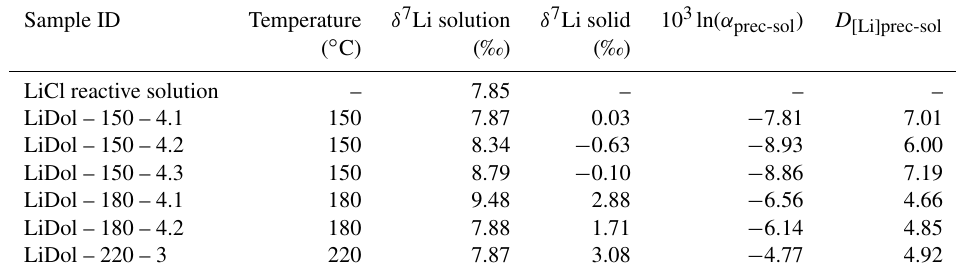
Table 2. Li isotope composition in solutions and precipitated solids for the precipitation experiments. Sample ID